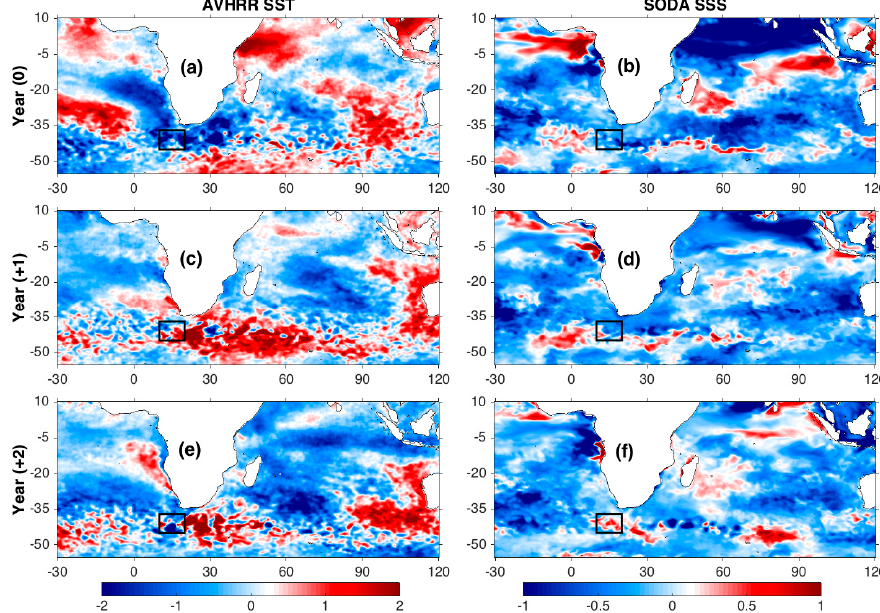
Figure 9. Same as Figure 8 except in reference to the strong 1997–1998 El Niño minus the weak 2004– 2005 El Niño during the peak ( a , b ), the following year ( c , d ), and two years after ( e , f ).